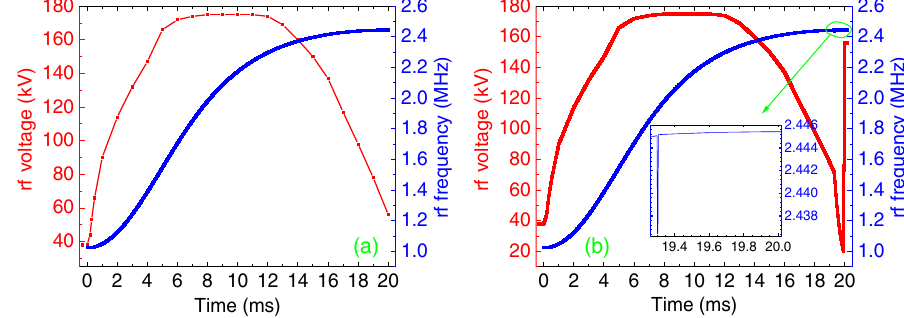
FIG. 1. The rf voltage and frequency patterns: (a) the normal operation mode; (b) the short bunch extraction mode. The rf voltage and frequency patterns before extraction are modified to accomplish the bunch compression and the desynchronization between the rf and magnetic fields (see Sec.